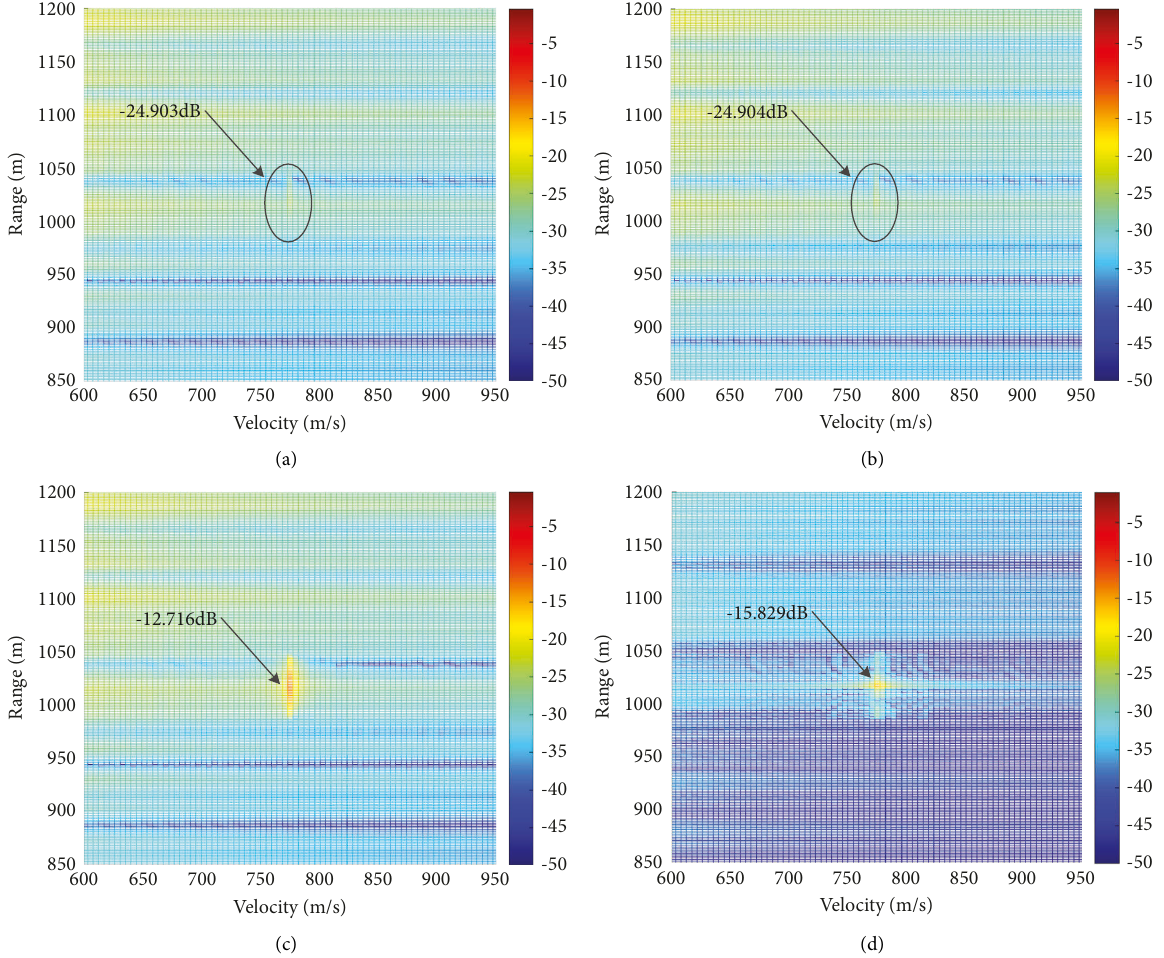
Figure 11: The Range-Doppler spectrum of different targets under different bandwidths. (a) Point target, B � 5M Hz; (b) conductor metal ball, B � 5M Hz; (c) missile-like target, B � 5M Hz; (d) missile-like target, B � 60M